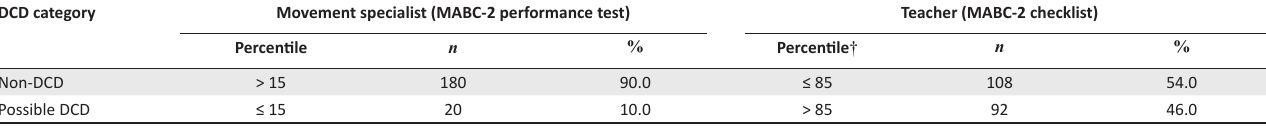
TABLE 3: Percentage of learners ( N = 200) without or with possible developmental coordination disorder. DCD category